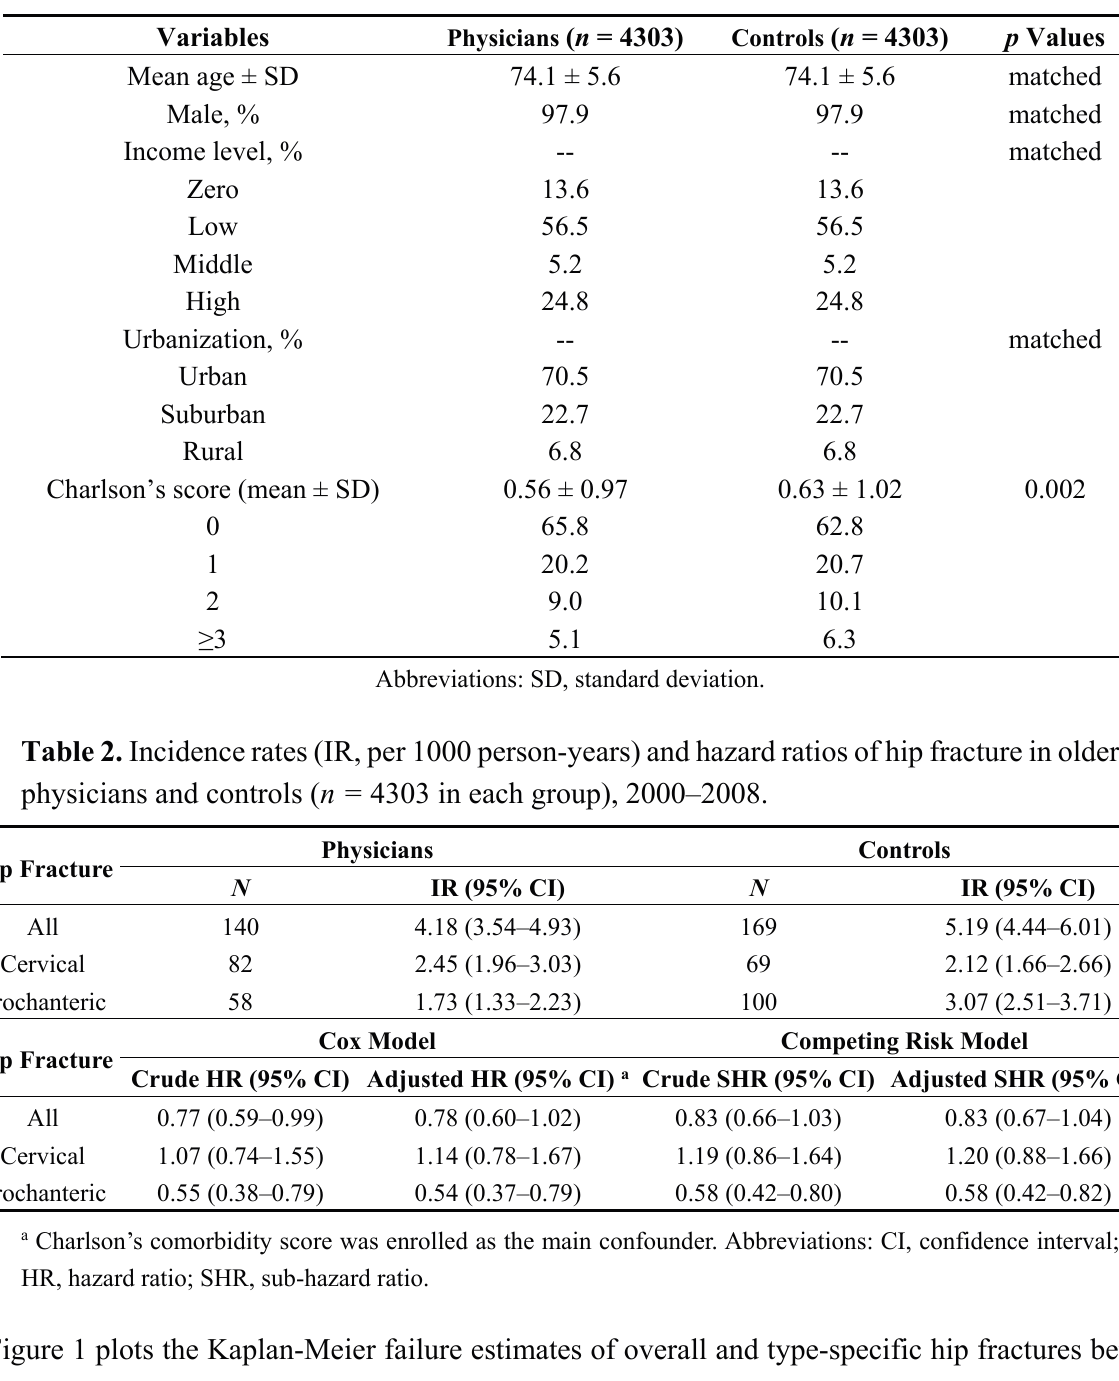
Table 1. Baseline characteristics of older physicians and controls.